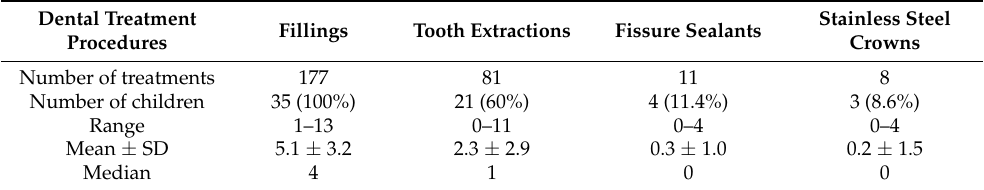
Table 3. Dental procedures performed under general anaesthesia.